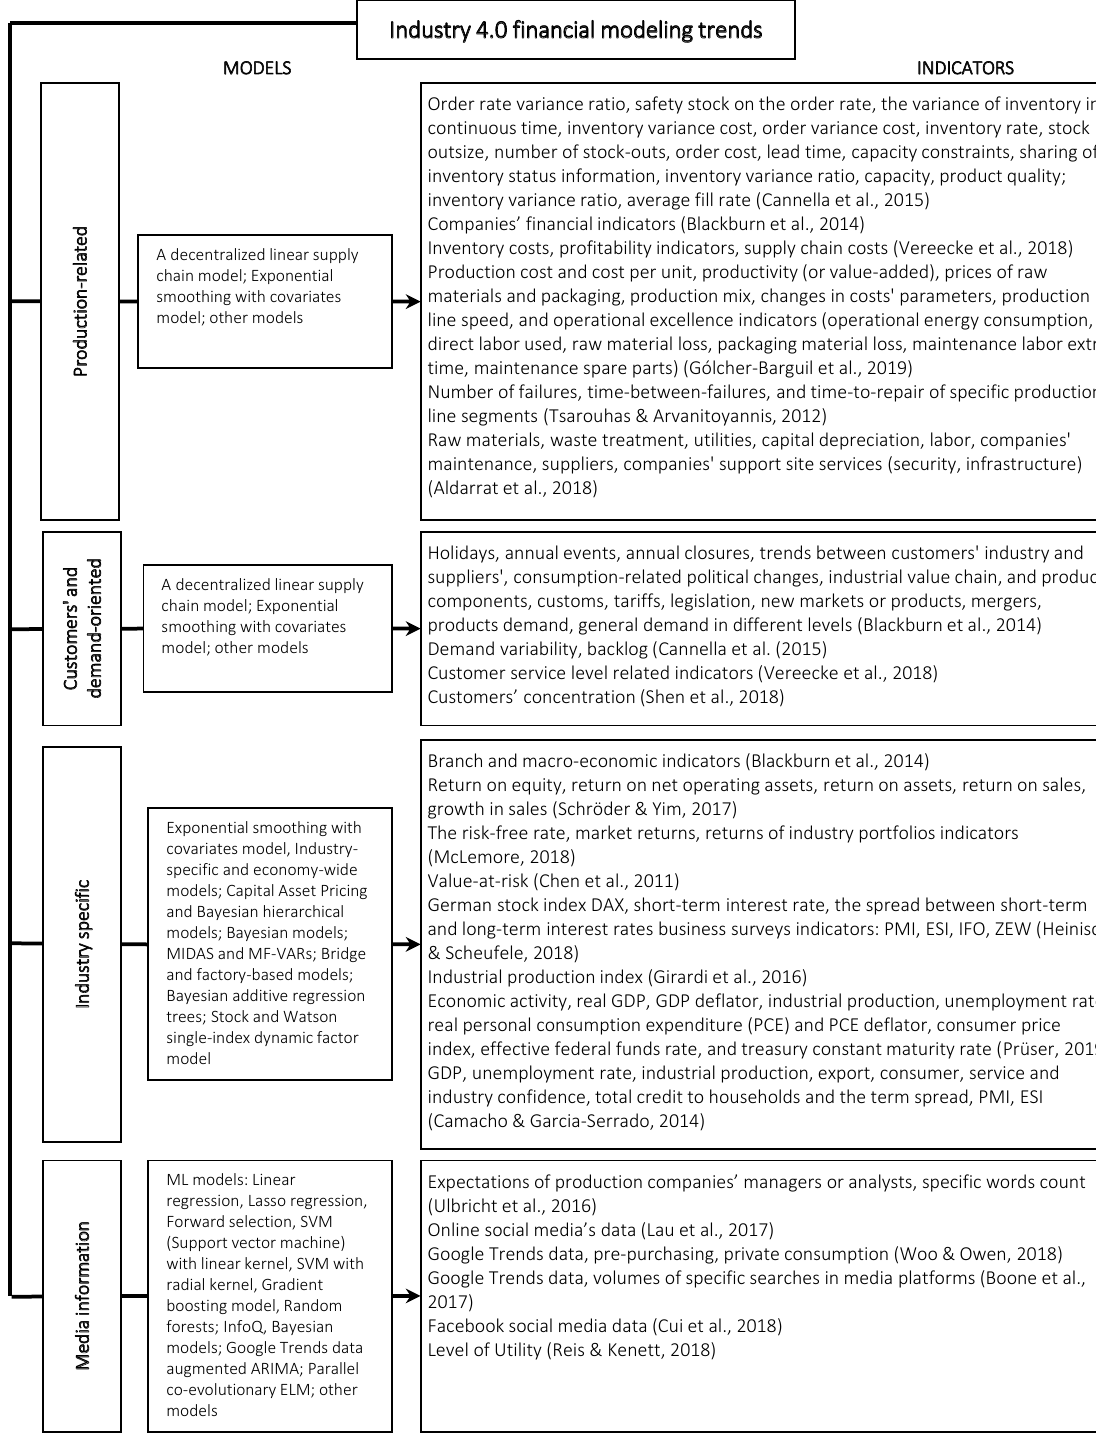
Figure A2. Industry 4.0 financial/economic forecasting models and indicators by analyzed